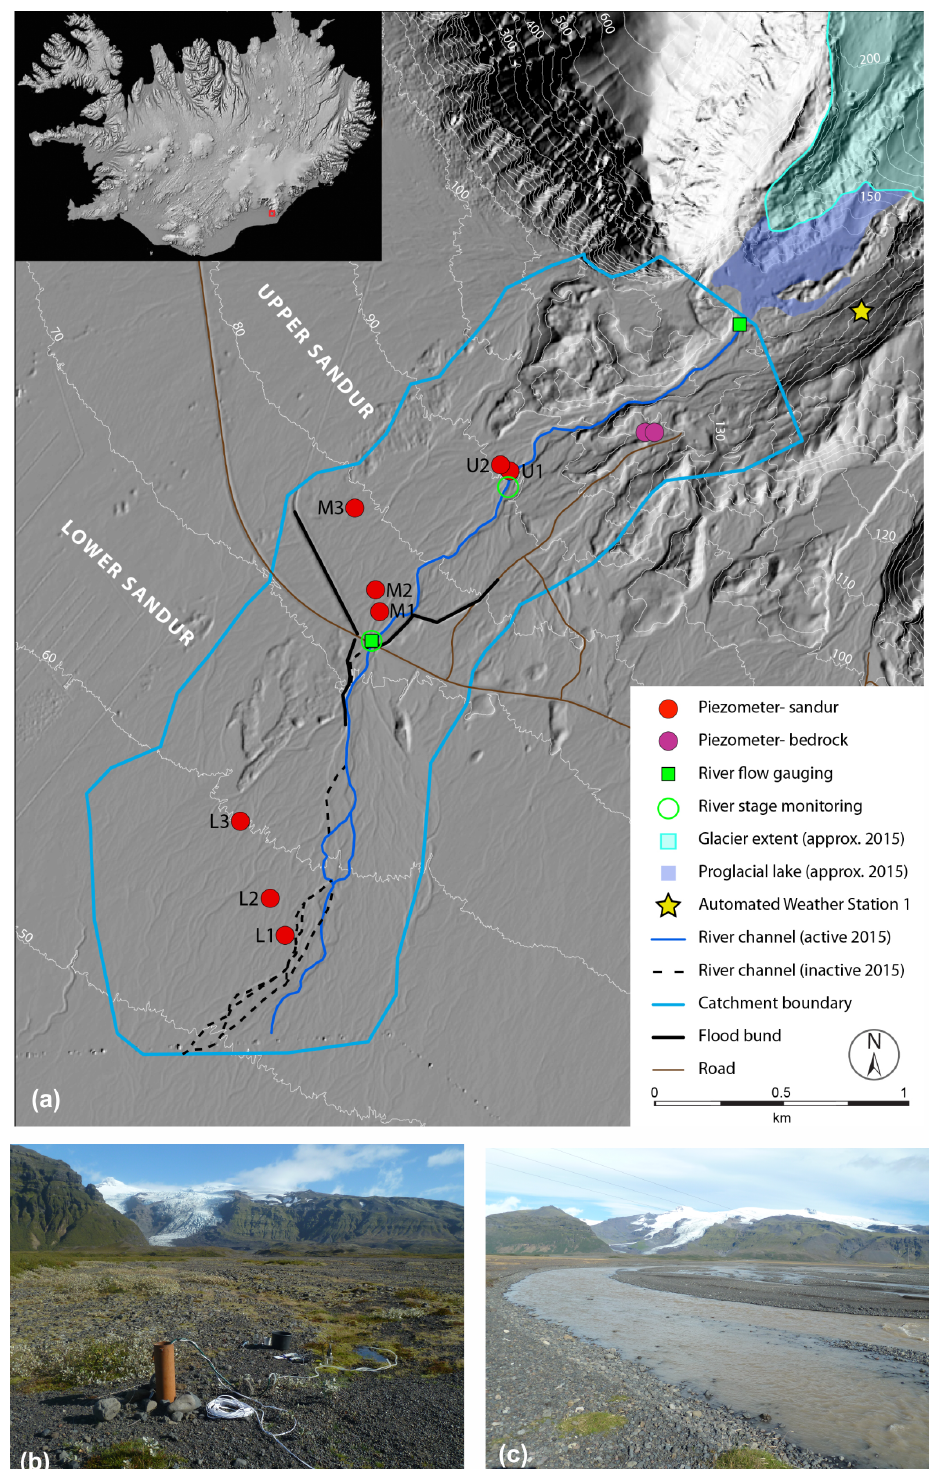
Figure 1. Virkisjökull study catchment. (a) Study area on Virkisjökull sandur, south-eastern Iceland, encompassing 6km 2 groundwater catchment originating at a proglacial lake outlet. Hillshade model generated from LiDAR DEM ©Veðurstofa Íslands, 2010. (b) Piezometer M1 on the upper sandur near the catchment edge, showing established sandur vegetation and, in the middle distance, the area of moraines. (c) Virkisá River on the lower sandur in the summer melt season showing braided channels and an active, unvegetated sandur surface. Piezometers in the sandur are in three transects: Upper (U1–U2), Middle (M1–M3), and Lower